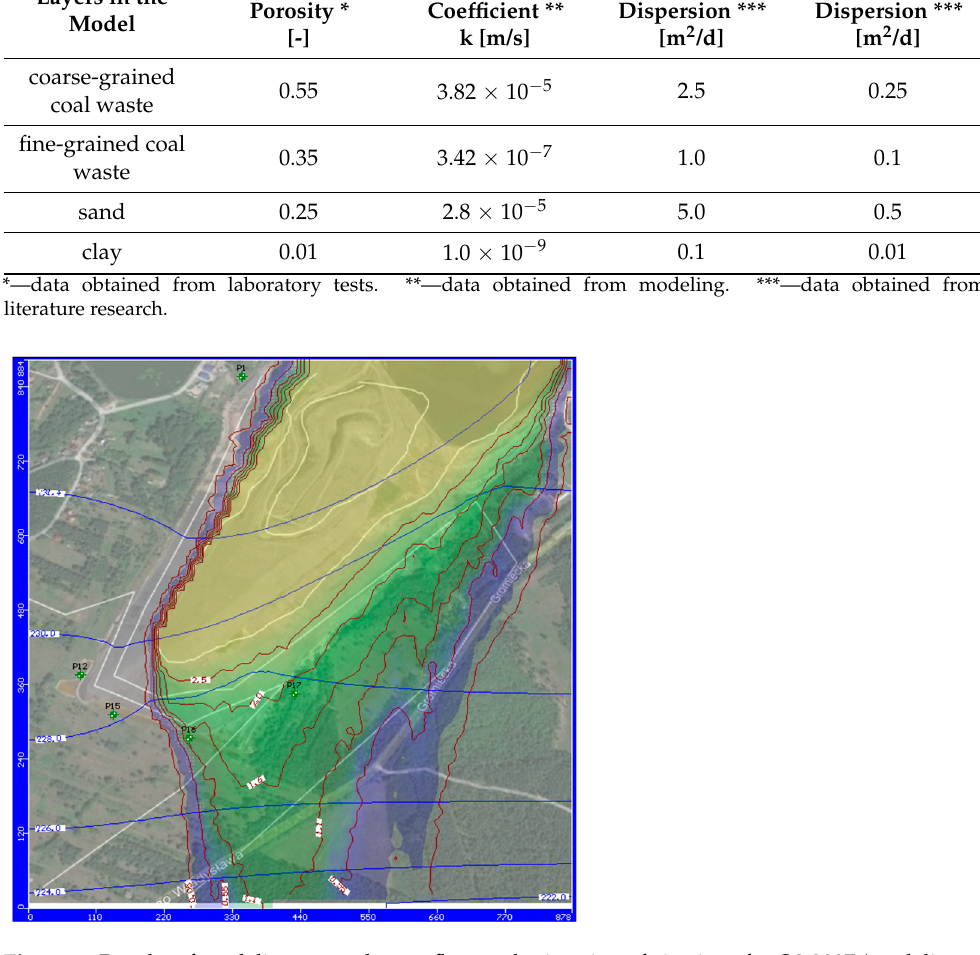
Figure 5. Results of modeling groundwater flow and migration of zinc ions for Q2 2007 (modeling of Zn(II) migration for the steady-state conditions lasted two years). P1, P12, P15, P16, P17—piezometers; numbers in the two blue axes—distance in meters; blue numbers—the height of the groundwater table; red numbers—concentration of Zn(II).